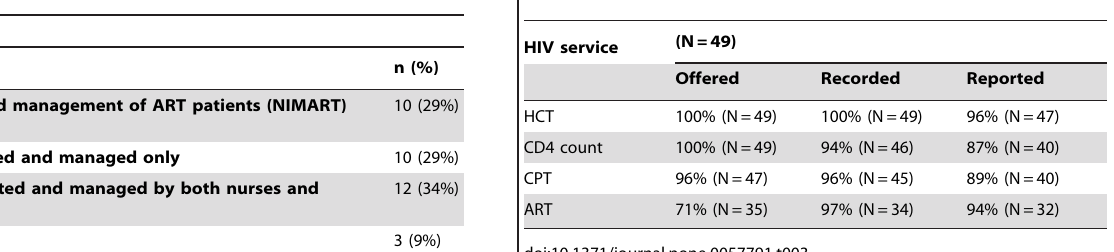
Table 2. Method of Initiation and management of ART patients among facilities offering ART (N =35), South Africa, March 2011.